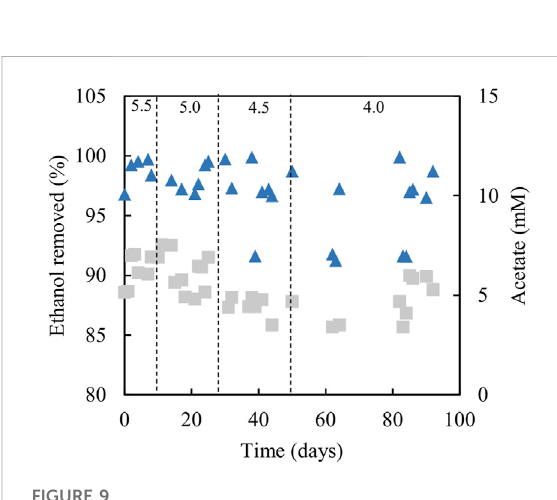
FIGURE 10 Terminal restriction enzyme fragment length polymorphism (T-RFLP) analysis (HaeIII digests) of ampli fi ed 16S rRNA genes of planktonic bacterial communities in the sul fi dogenic bioreactor fed with ethanol alone, at different pH values. Shades of blue represent known sulfate-reducing Firmicute (215 nt, D. acididurans ), shades of yellow represent non-sul fi dogens (230 nt, Actinobacterium AR3; 253 nt, At. ferrooxidans ), shades of green represent bacterial clones identi fi ed as probable non-sul fi dogens and the magenta bars represent clone SRB7 (201 nt; the sul fi dogenic Gram-negative bacterium Dv. desulfuricans